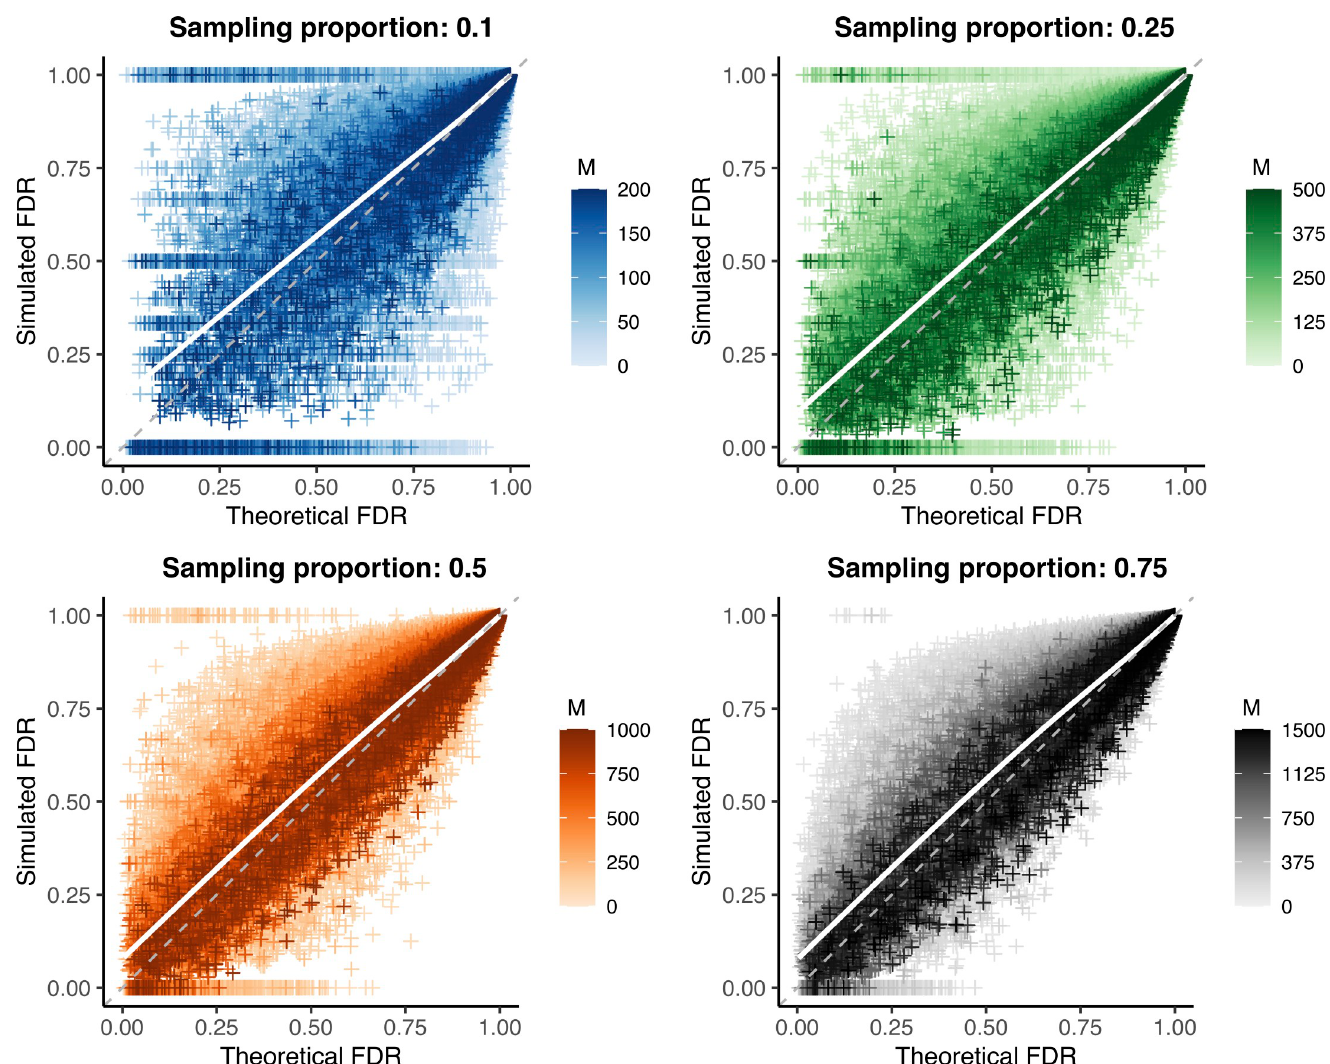
Fig 4. Validation of substitution rate method to calculate sensitivity and specificity. Theoretical versus simulated false discovery rate (FDR) for each genetic distance threshold in 10,000 simulations of varying substitution rate and reproductive number (approximately 260,000 points per plot, see Tables 2 and 3 ). Outbreak sizes range from 100–2000, as described in Methods . White line: smoothed conditional mean; grey dashed line: y = x line. Increasing values of the sample size ( M ) are plotted in darker color; increasing both the sample size and proportion reduces bias and error, see S2 and S3 Tables